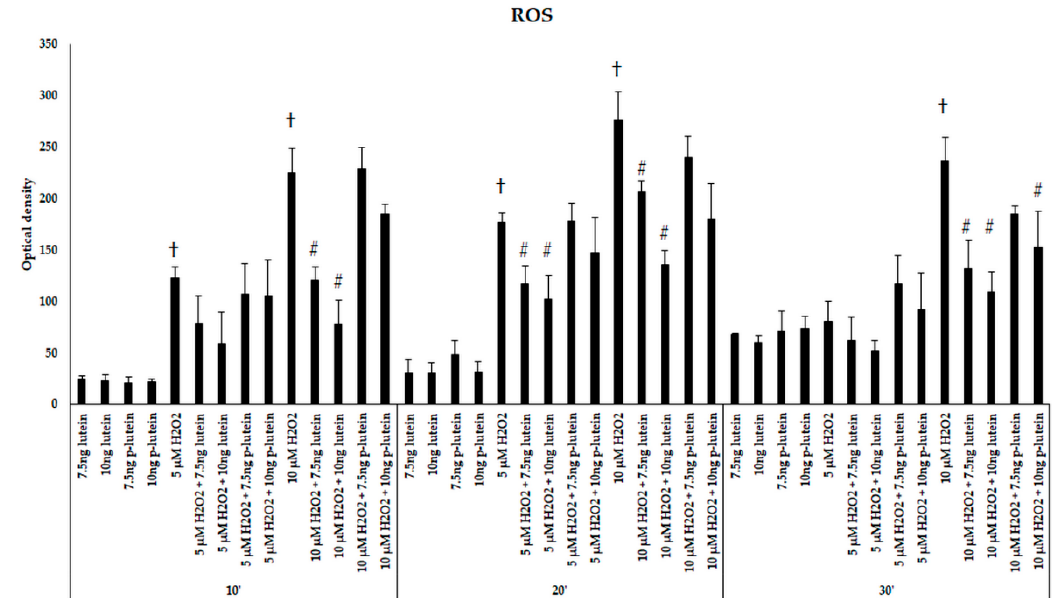
Figure 1. Reactive oxygen species detection after lutein and H 2 O 2 treatment in BV-2 cells. The columns represent the mean values and error bars indicate the standard deviation (SD) of three independent experiments ( n = 3), each performed in quadruplicate, and are presented relative to own control cells. † indicates statistical significance of H 2 O 2 treated cells compared to controls, # marks statistical significance of combined (lutein with H 2 O 2 ) treatments compared to H 2 O 2 treatments; the level of significance was p < 0.05. Abbreviations: p-lutein is 24 h of lutein pre-treatment, 10 (cid:48) –10 min, 20 (cid:48) –20 min, 30 (cid:48) –30